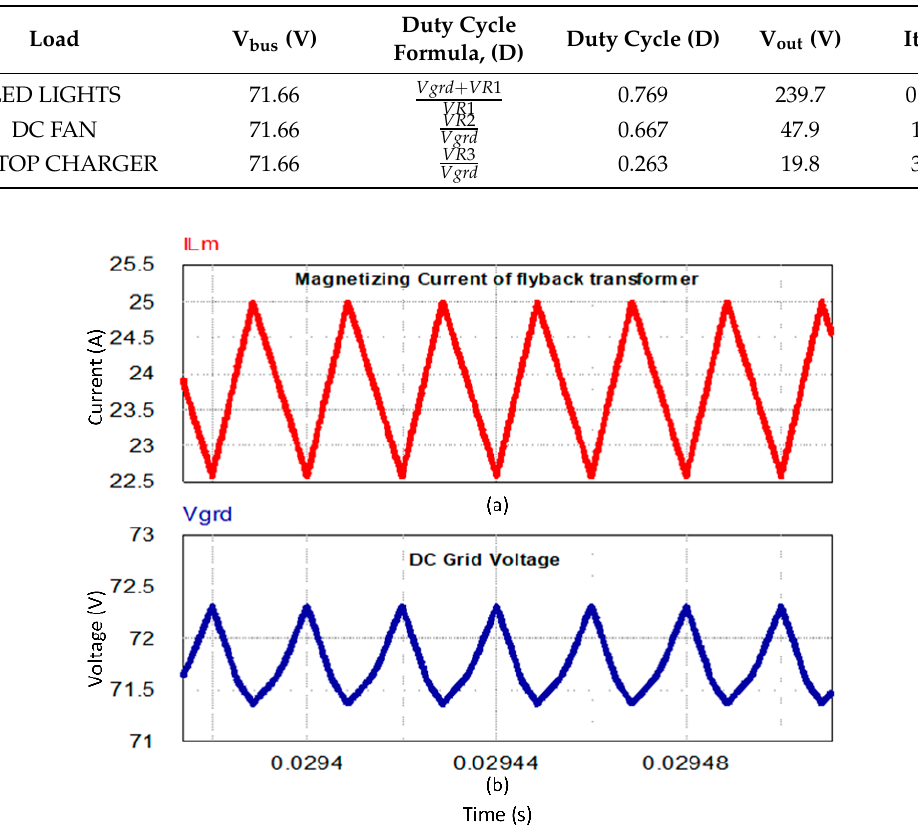
Figure 6. Output of Simulation DC-Grid Voltage. Average Voltage = 71.6 V, voltage ripple = 0.9% and output of Simulation—magnetizing inductor current. Average inductor current 24.39 A, current ripple = 9.64%. ( a ) Magnetizing current of flyback converter; ( b ) DC grid voltage.